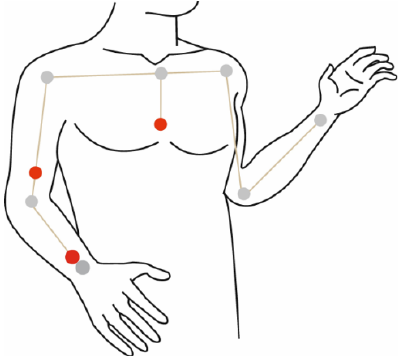
Figure 1. Biomechanical model of the human body.